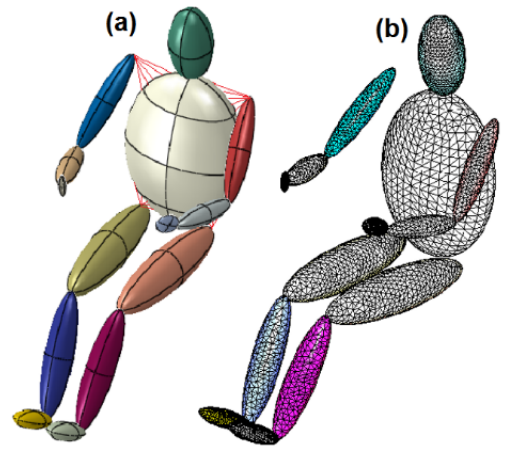
Figure 3. ( a ) Interconnected portions and ( b ) meshed body.